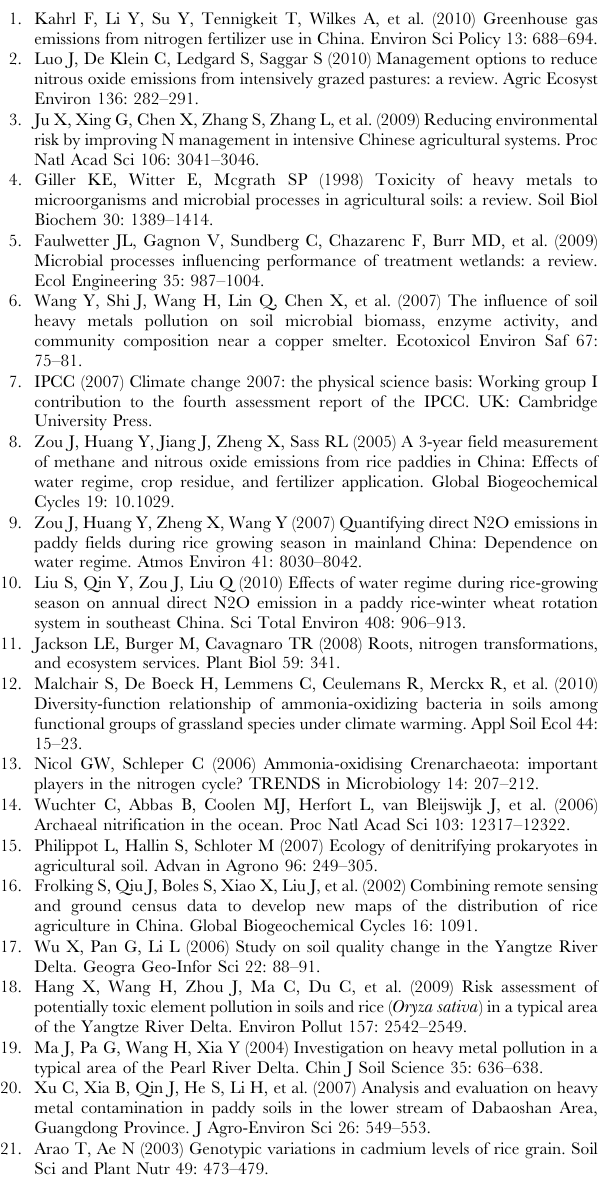
DBS. Arrows indicate the excised bands (B17–B27 and K14–K22) for sequencing. (TIFF) Table S1 Primer sets and thermal profiles used for the absolute quantification of functional target